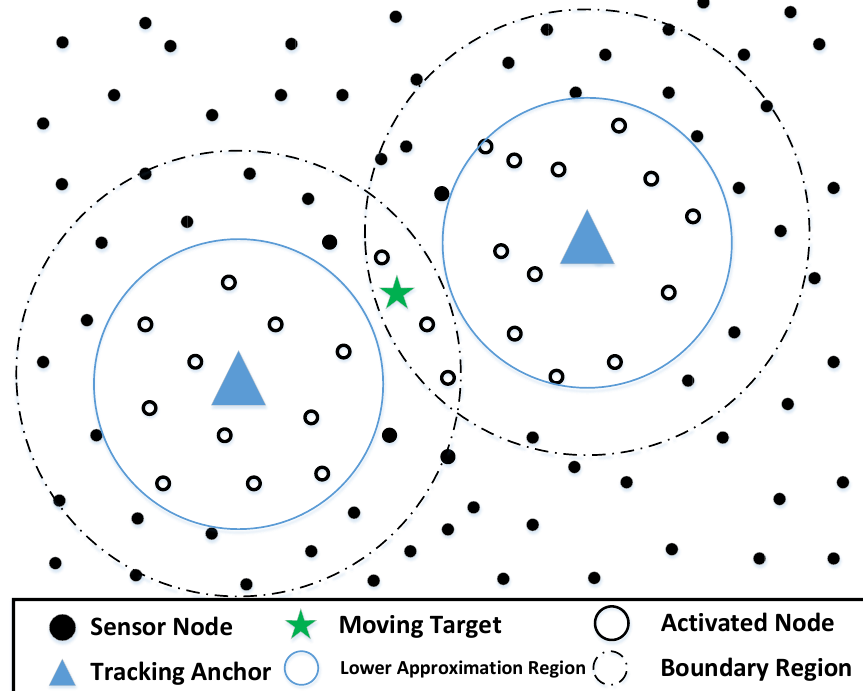
Figure 6. Sensor Activation Scenario